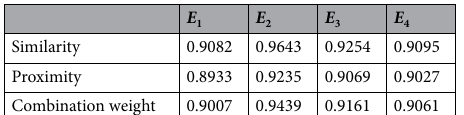
Table 5. Similarity, proximity and combination weight of decision-makers under attribute C 1 .